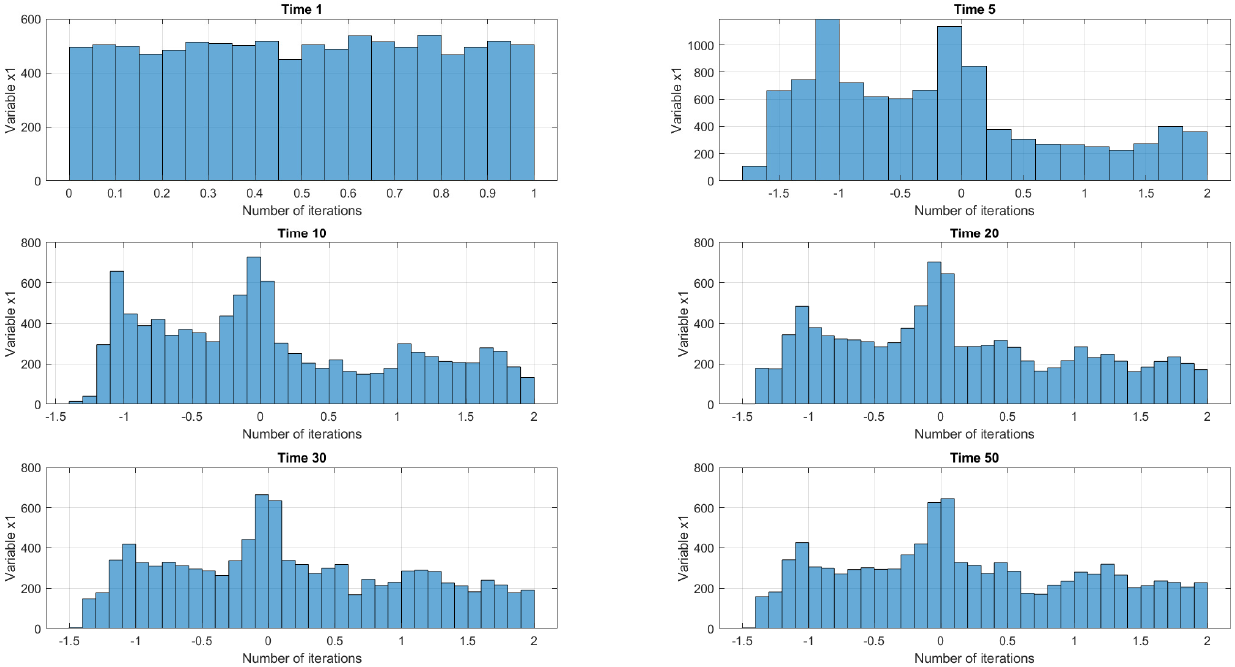
Figure 7. Transient time—Clifford map—histograms for variable x 1